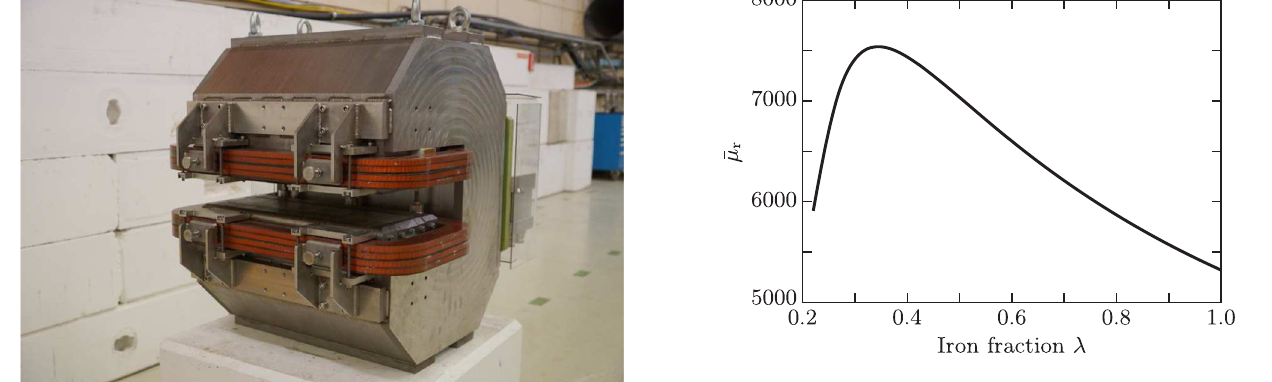
FIG. 7. Average permeability of steel I for different iron fractions by using measurement results performed with mixed samples.